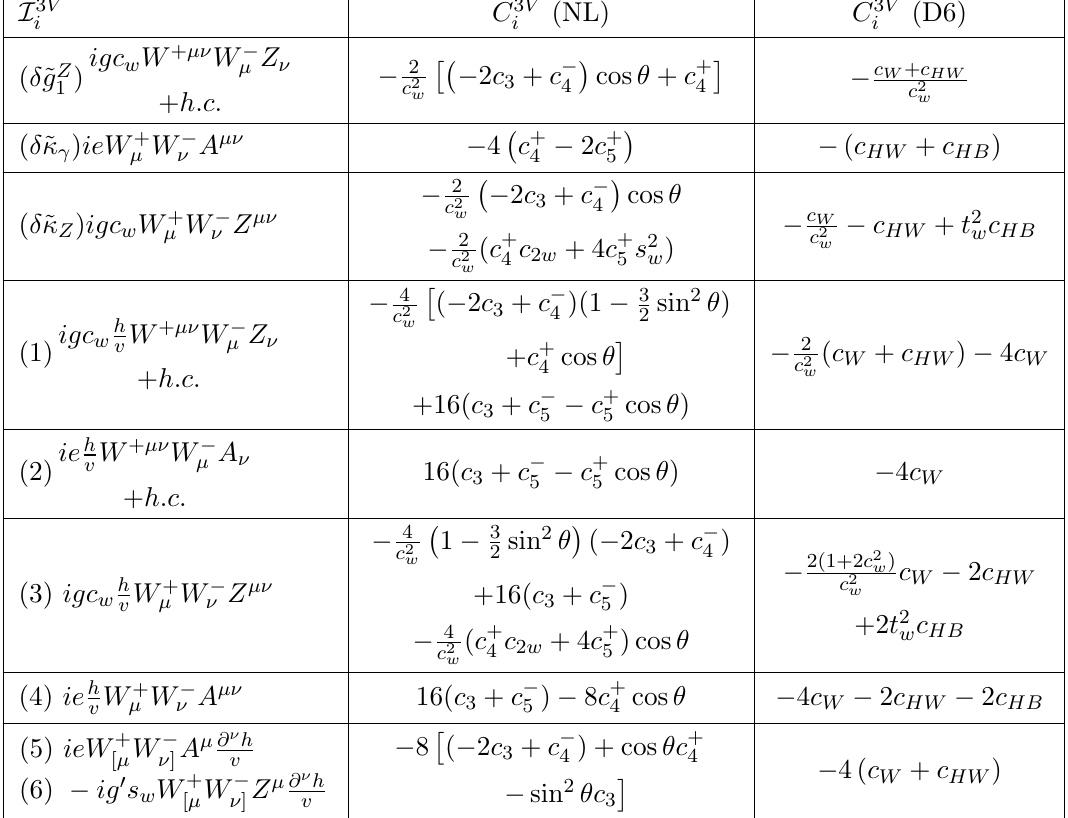
Table 3. Triple gauge boson couplings involving one or no